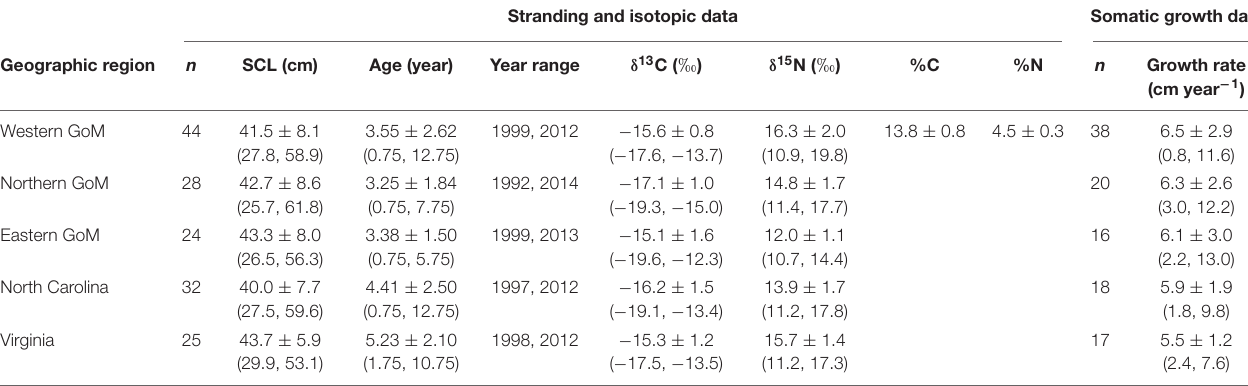
TABLE 3 | Summary characteristics for Kemp’s ridley sea turtle bone growth layers sampled for stable isotope values. Stranding and isotopic data Somatic growth data